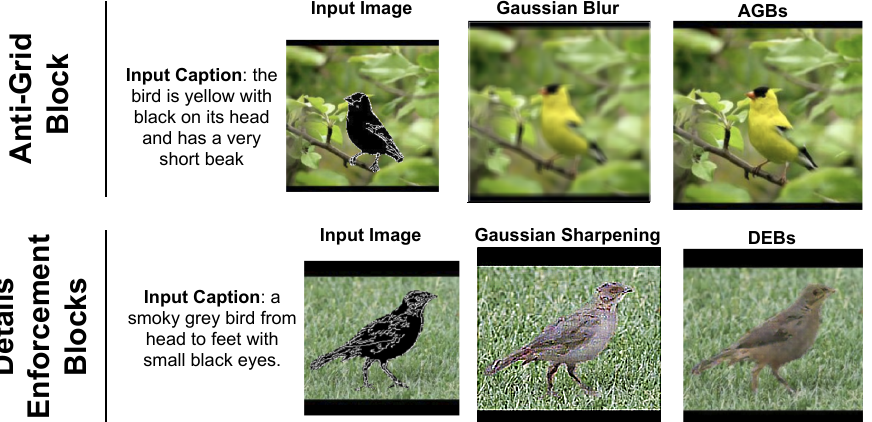
Figure 13. Gaussian Blur and Sharpening global action are compared to the AGB and DEB local action.